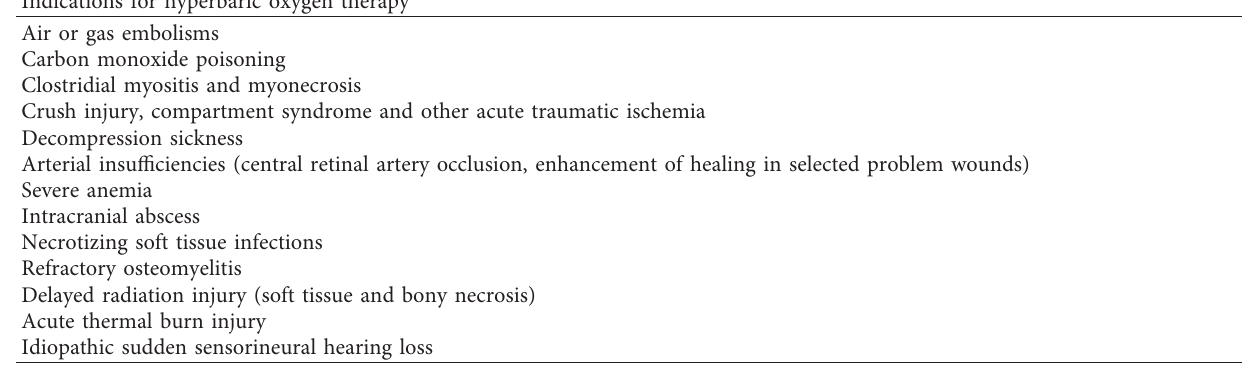
Table 3: HBOT indications [9].